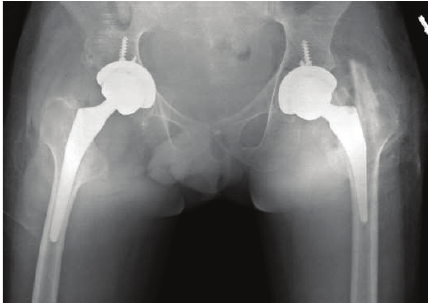
Figure 2: Anteroposterior both-hip radiograph depicting bilateral cemented THA at last